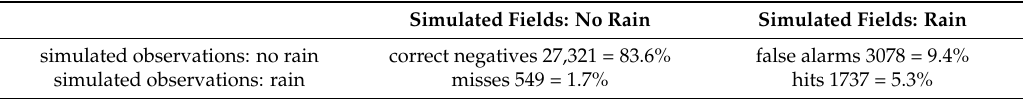
Table 3. Probability of detection (POD), critical success index (csi), bias score, success ratio, and accuracy for collocated events of ERA-Interim rain data with rain measurements and simulated data according to contingency Tables 1 and 2.